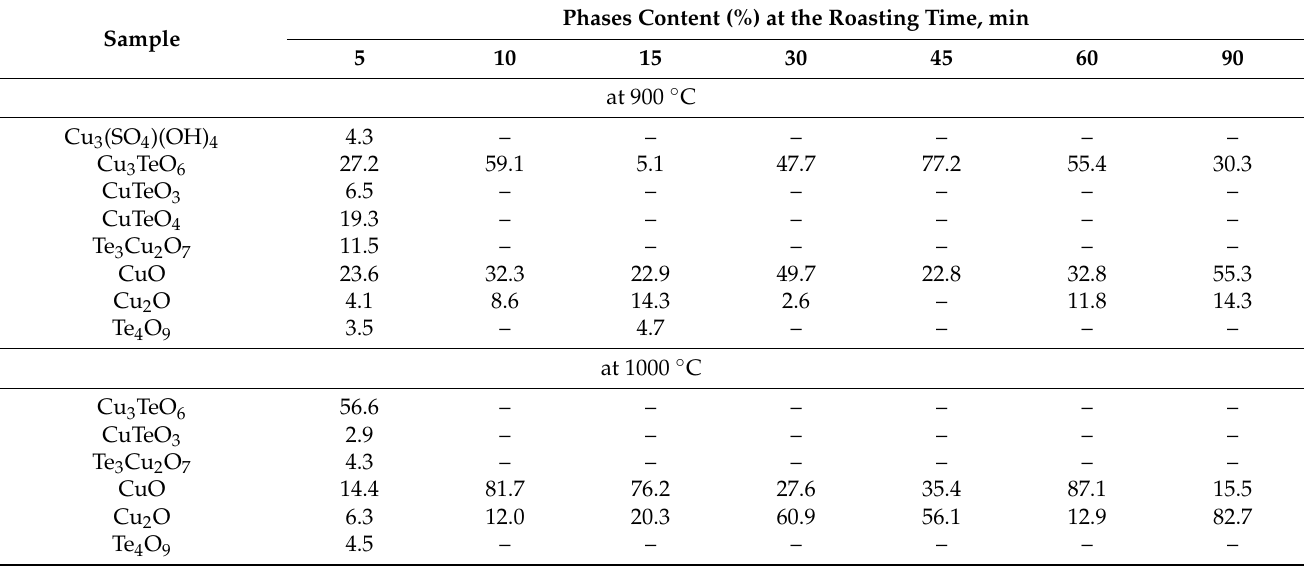
Table 3. Phase composition (wt %) of high-temperature roasting residues (for Figures 6 and 7). Sample Phases Content (%) at the Roasting Time, min